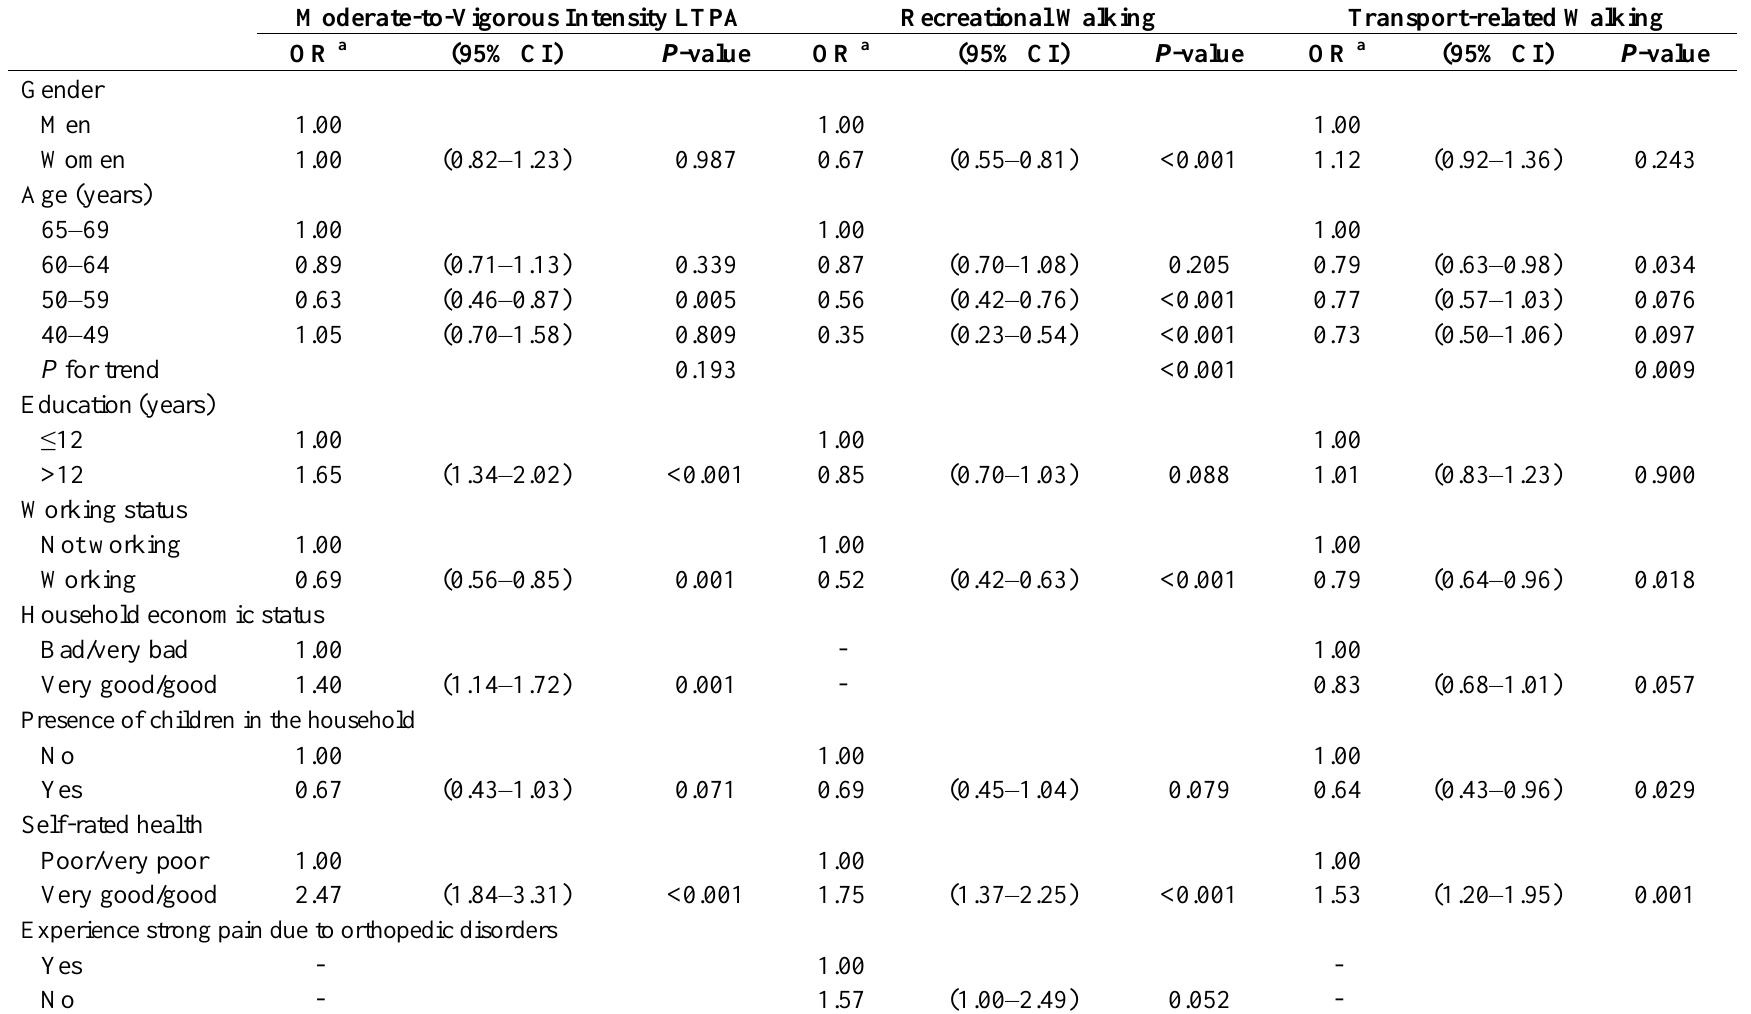
Table 2. Adjusted odds ratios for individual and neighborhood environmental characteristics for moderate-to-vigorous intensity LTPA (n = 1,940) and recreational (n = 1,937)/transport-related (n = 1,896)